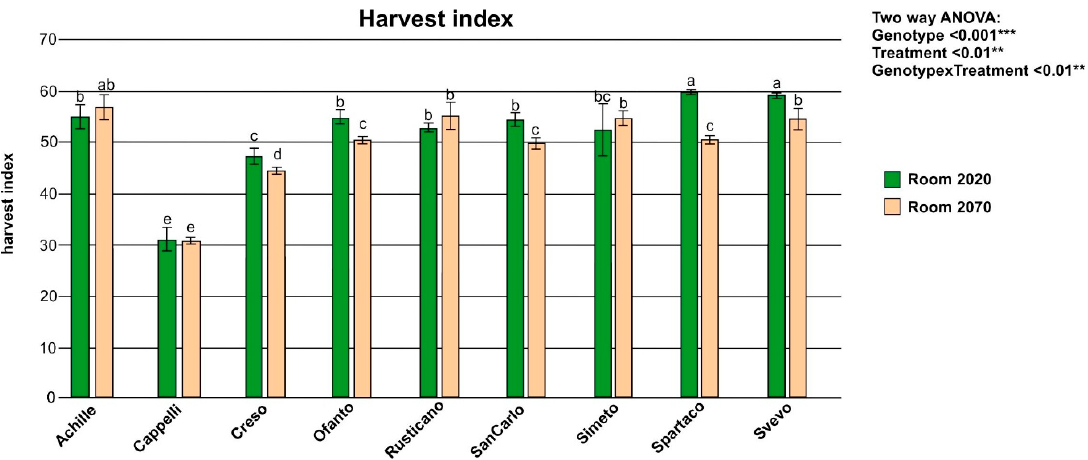
Figure 6. Harvest index per cultivar grown in “room 2020” and “room 2070”. Top right: Two-way ANOVA results (*** p < 0.001; ** p < 0.01). Letters (a), (b), (c), (d), and (e) refer to significantly different means across the genotypes and the treatment (Tukey-HSD post hoc test, p < 0.05).